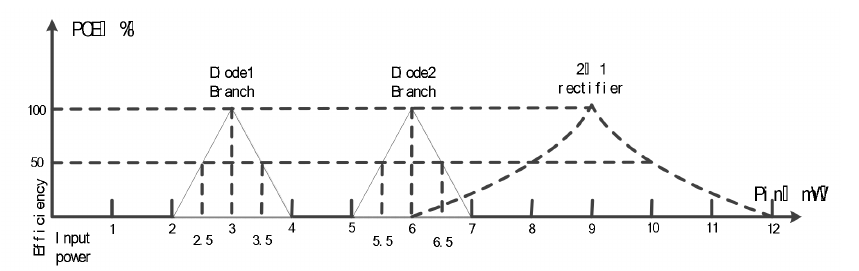
Figure 13. The mathematical model of the wide-dynamic dual RF-DC microwave rectifier